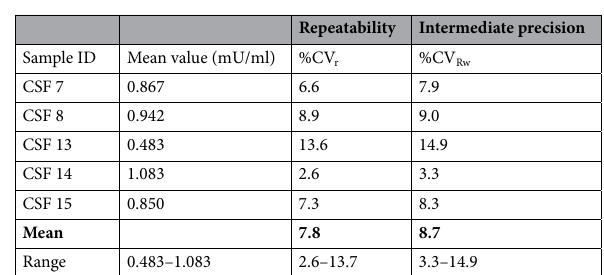
Table 3. Precision of five different CSF samples.